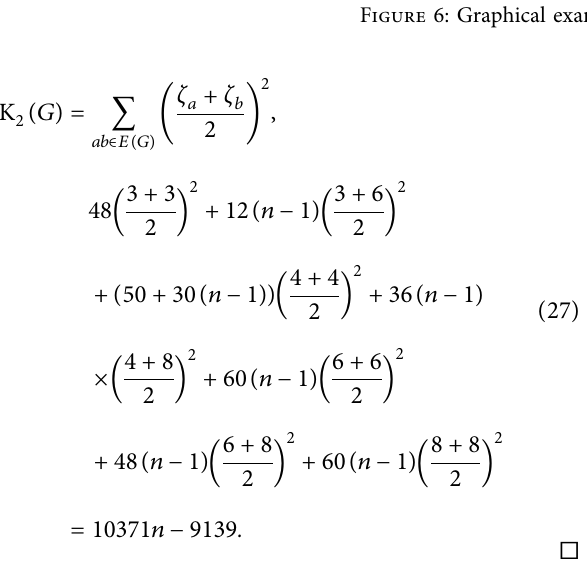
Figure 6: Graphical examples for SK, SK